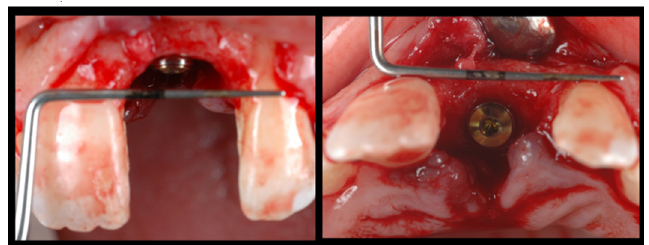
Figure 5. With the help of a surgical guide, implants were positioned in the correct 3D position.